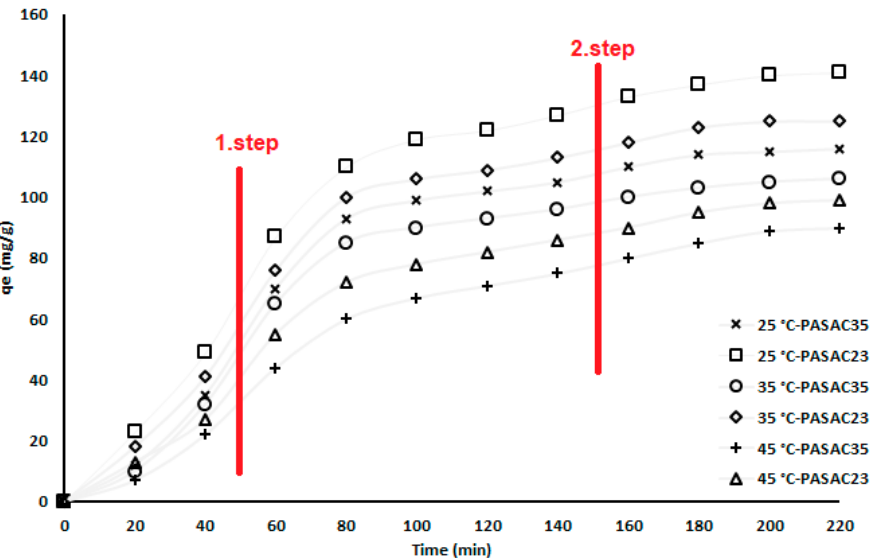
Figure 6. Influence of contact time on the performance of benzene adsorption.